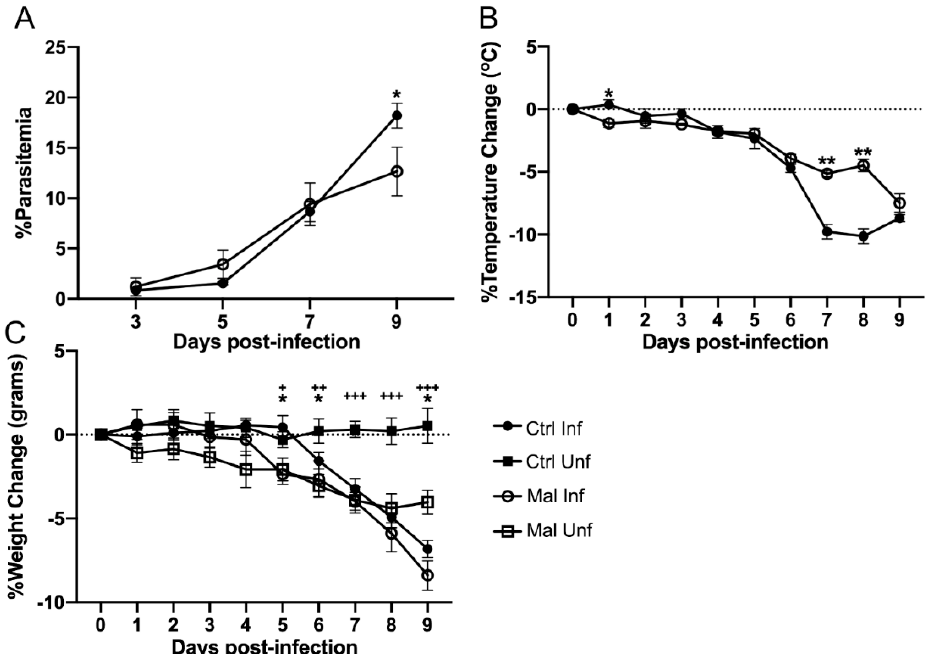
Figure 1. Parasite burden and pathological responses of control and moderately malnourished mice after infection with 1 × 10 5 P. chabaudi . ( A ) Percent parasitemia. ( B ) Percent temperature change. ( C ) Percent change in body weight. All data are shown as means ± SE, n = 3 male mice per group, representative of 16 independent experiments. Statistical analysis was performed using a two-way ANOVA. +, * p < 0.05; ++, ** p < 0.01; +++ p < 0.001, indicates a statistically significant difference between treatments.